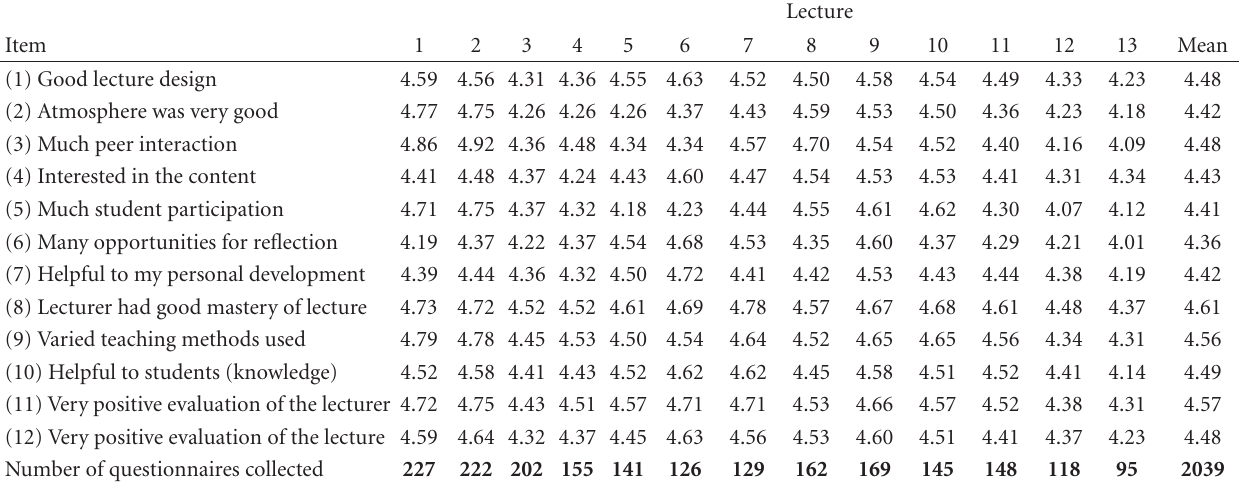
Table 2: Subjective outcome evaluation of each lecture.